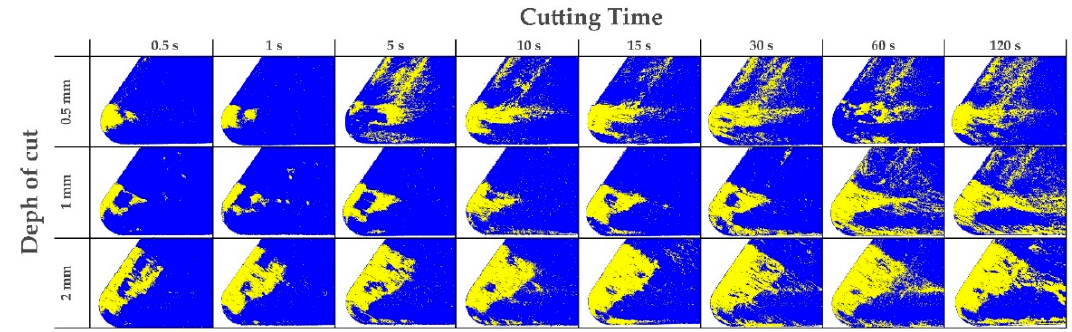
Figure 4. Secondary adhesion wear evolution in the zenith plane, evaluated with phase contrast analysis.